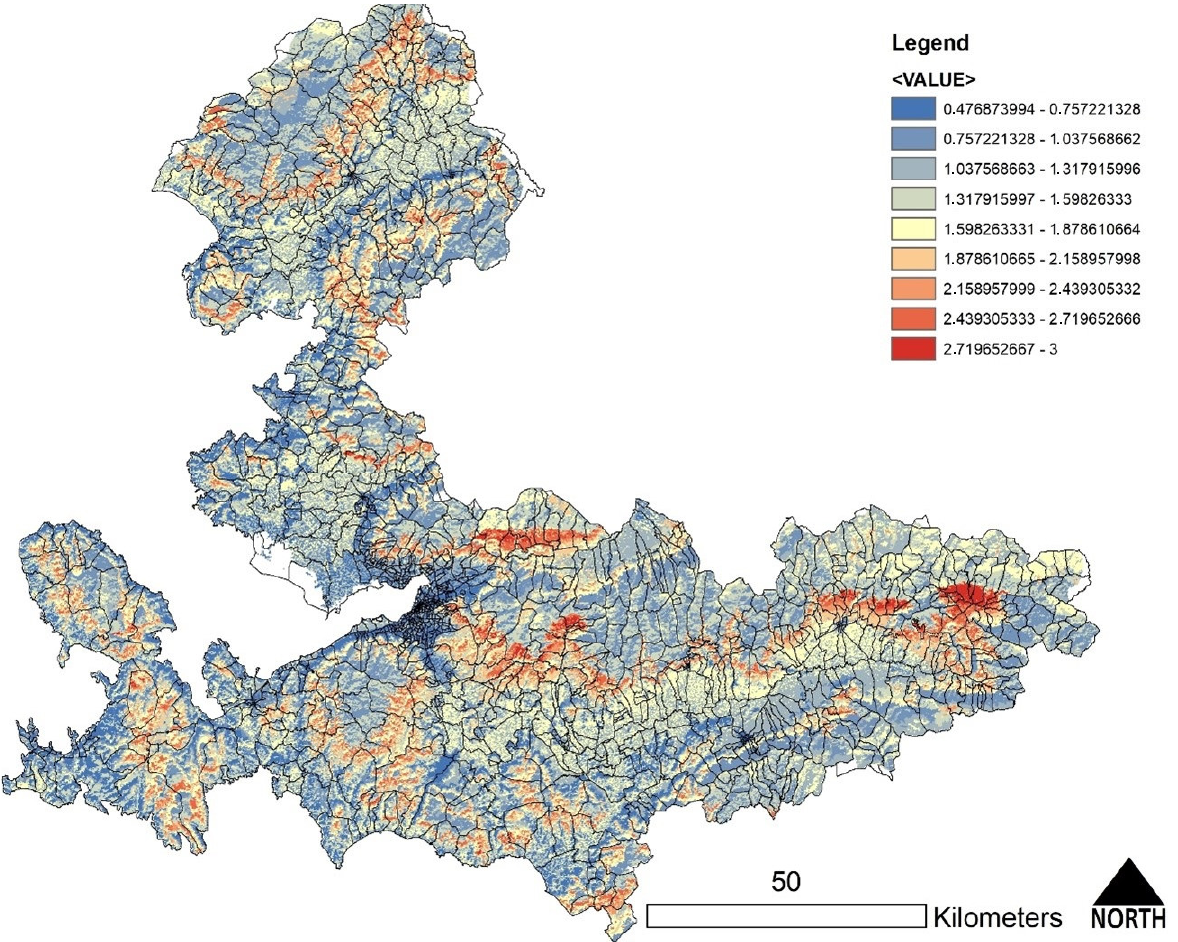
Figure 4. Principal Component Extraction. Source: author’s elaboration.